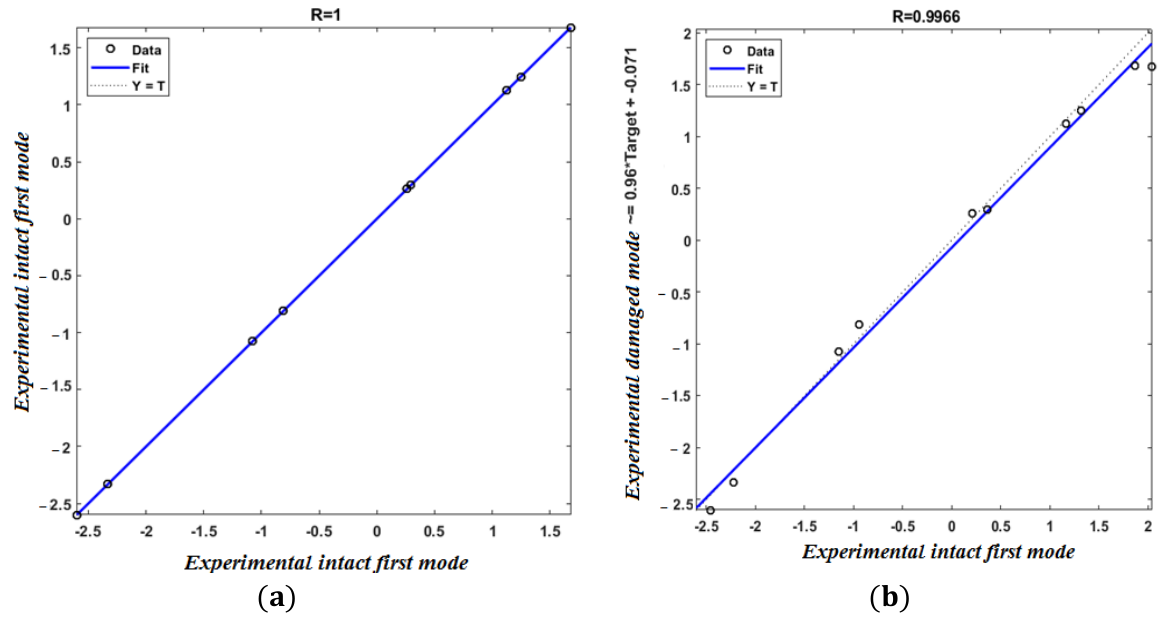
Figure 17. Experimental damaged and intact first mode shapes.